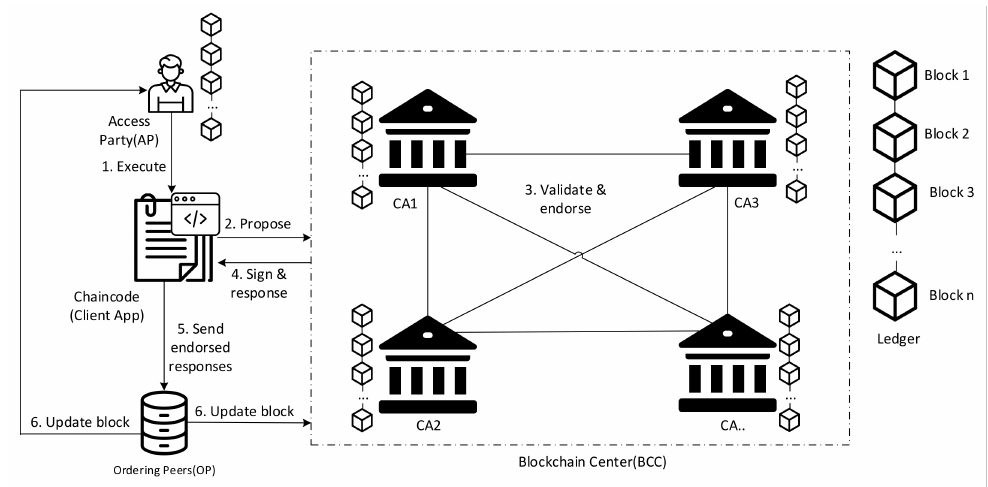
Figure 15. The mechanism of the blockchain architecture.